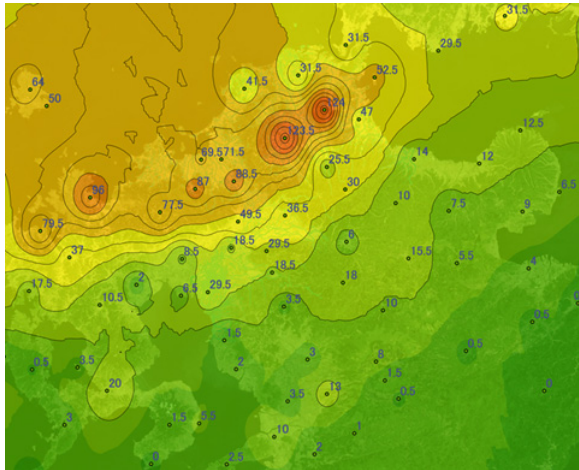
Figure 12. Enlargement of Figure 11 in the heavy rain area